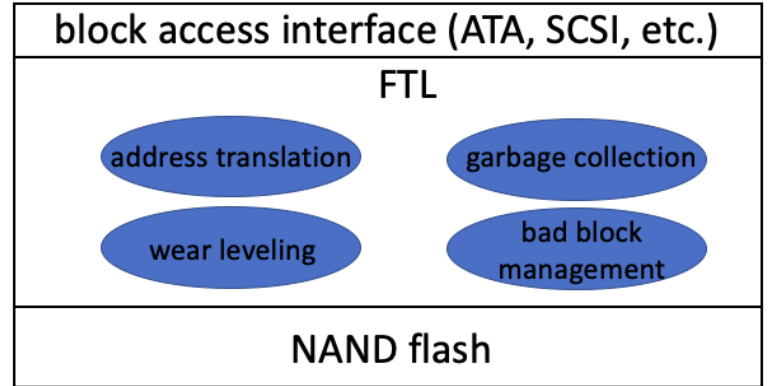
Figure 2. Flash translation layer